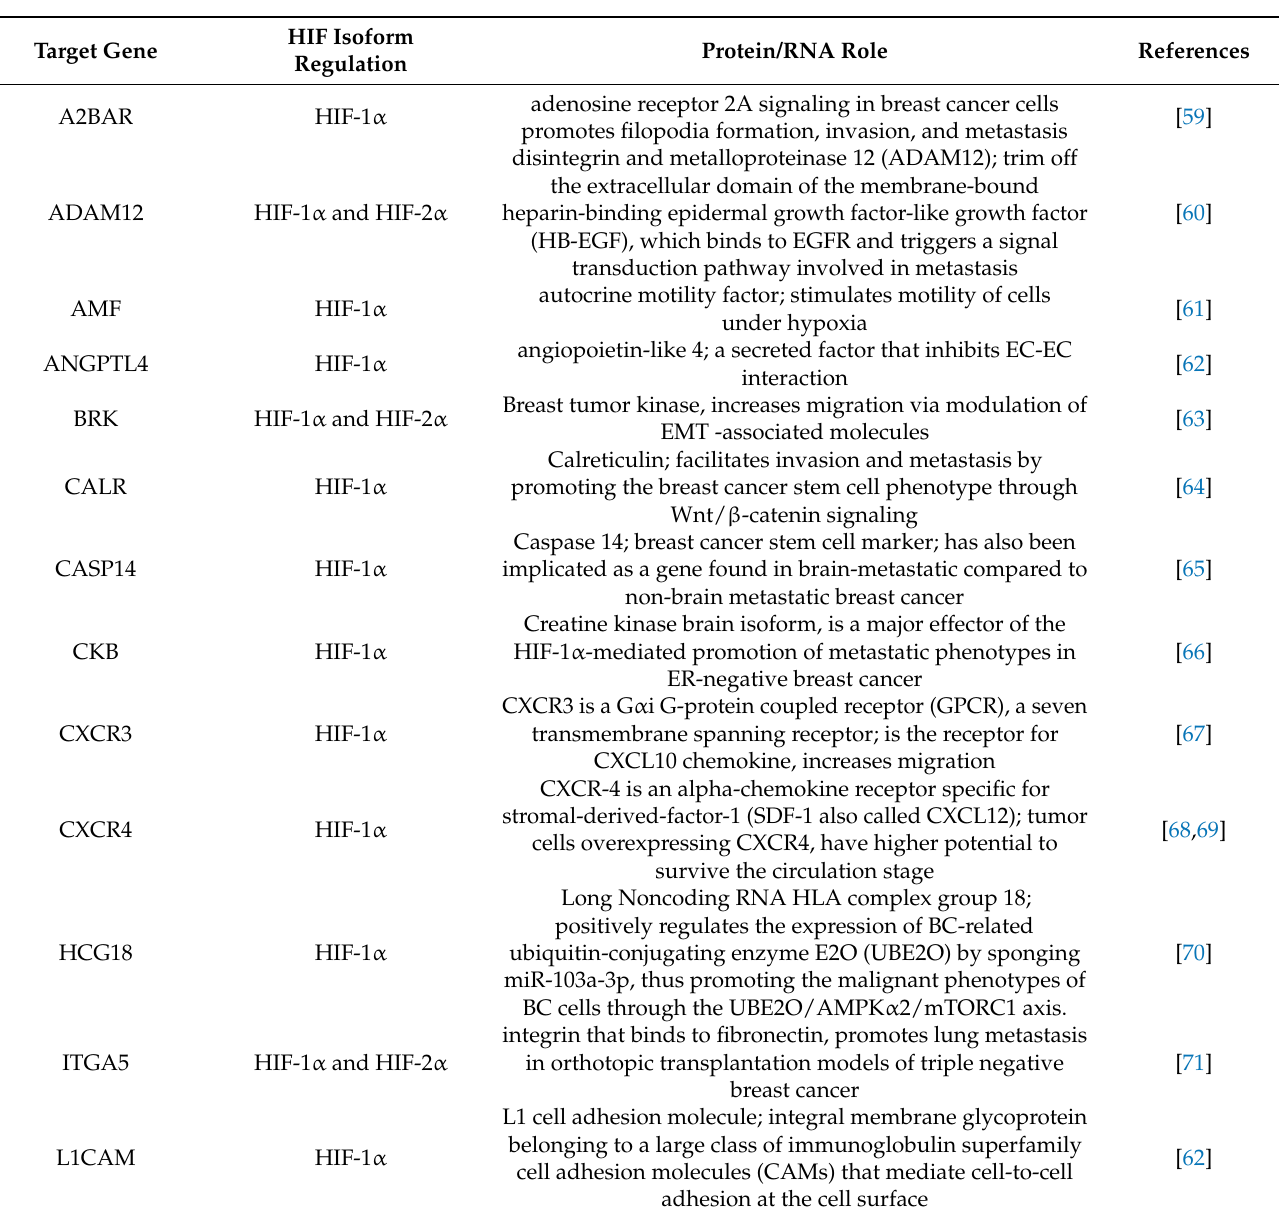
Table 1. Target genes of the hypoxia-inducible factors and their role in angiogenesis, invasion, and